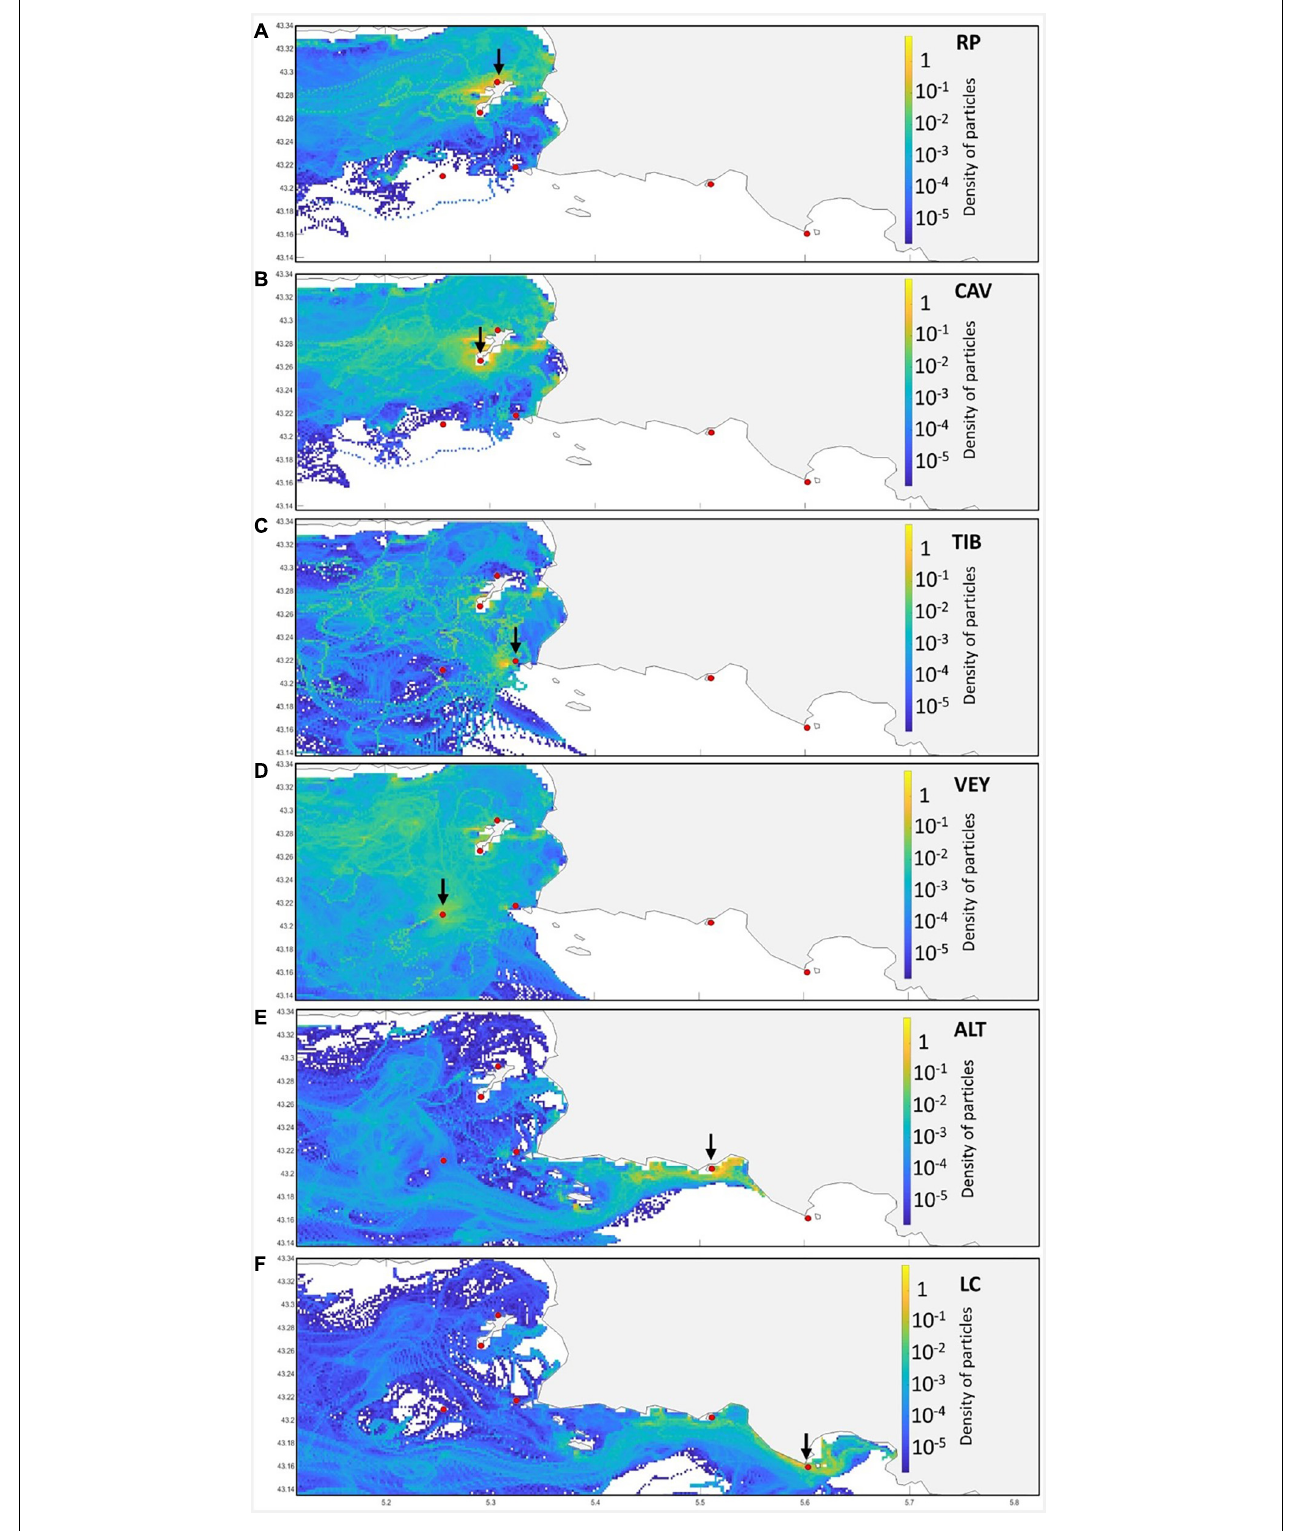
FIGURE 7 | An example of a probability density map of the distribution of particles recorded at the local scale (Marseille–La Ciotat) over Lagrangian simulations of the year 2014. Probabilities are color-coded in each mesh cell (resolution of 200 meters), indicating no particle record (white) from low (blue) to high probability (yellow). For each panel (A–F) , the black arrow indicates the source area considered among the six sites, materialized as a red dot.